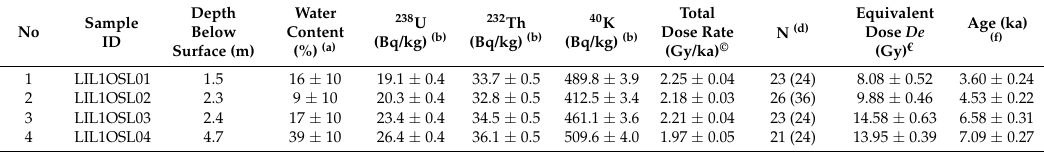
Table 1. Radionuclide concentrations, dose rates, equivalent doses, and OSL ages for samples collected from core